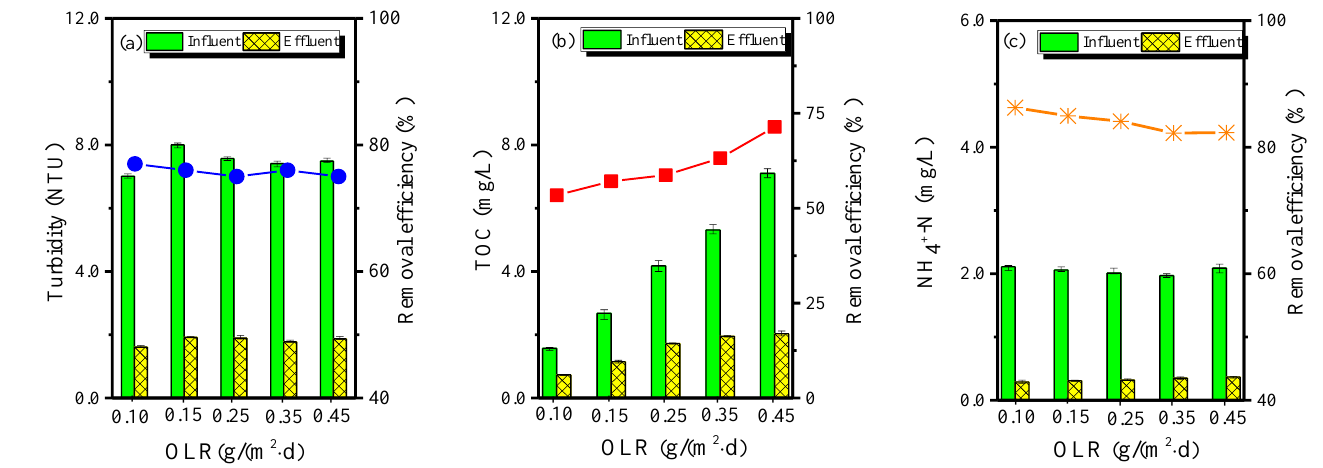
Figure 3. Effects of organic loading rates on the removal of turbidity ( a ), TOC ( b ), and NH + treating organic and NH + -N polluted water with the modified settling tank (HRT = 2.0 h and disc rotating speed = 3.0 r/min).